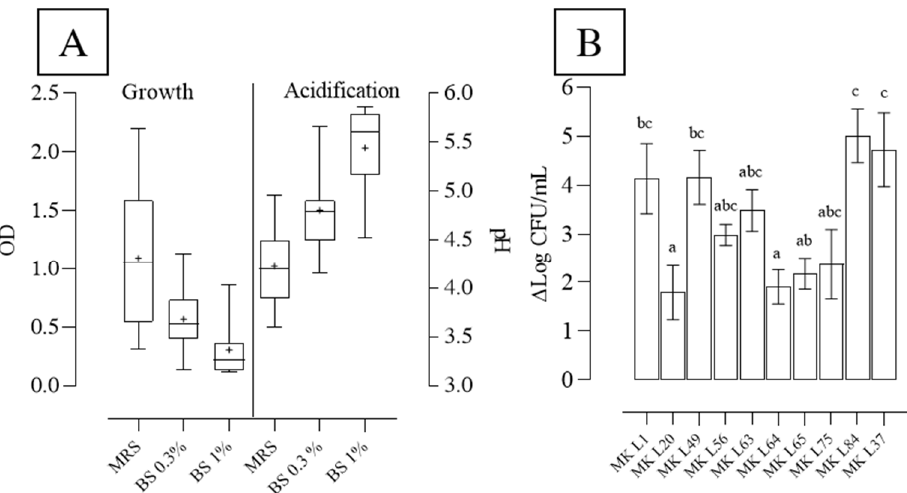
Figure 4. ( A ) Box plot representing growth measured by absorbance in MRS medium, MRS medium with 0.3% of bile salts (BS 0.3%), MRS medium with 1% of bile salts (BS 1%), and final pH in these three media, by the 14 lactic acid bacteria strains. The center line of each box represents the median, the mean is indicated by “+”, the top and bottom of the box represent the 75th and 25th percentile, respectively. ( B ) Differences in lactic acid bacteria cell counts (mean ± standard deviation, n = 3) between the initial concentration and after 4 h in acidic conditions. Different letters indicate significant differences among samples after 4 h ( p < 0.05).